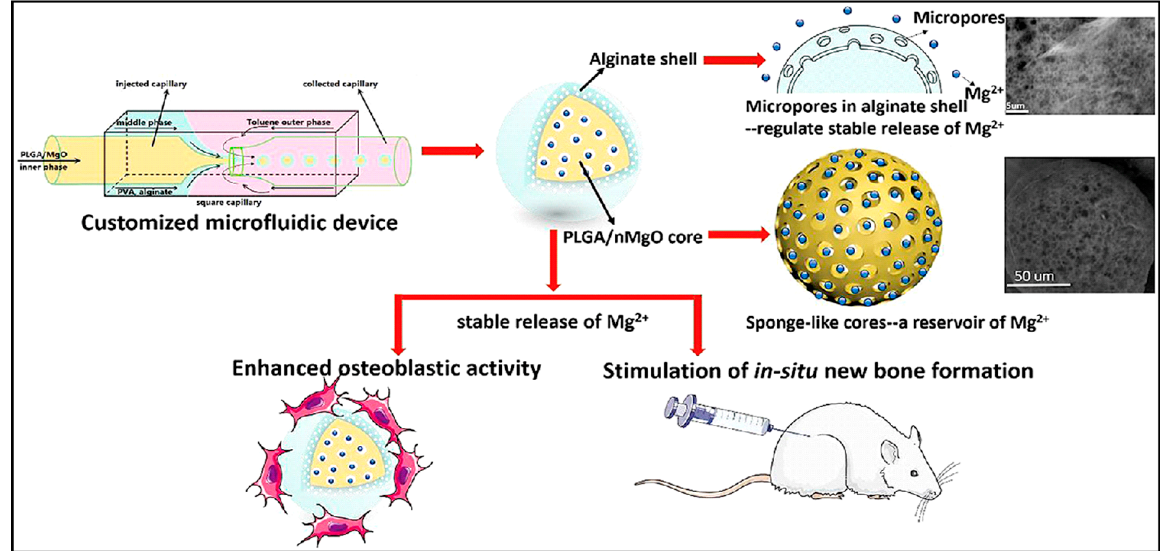
Figure 7. Schematic representation of PLGA/magnesium oxide nanoparticle core with alginate shell microsphere prepared using microfluidic capillary device and their osteoblastic activity in vitro and in situ bone regeneration in vivo. Reproduced with permission from [78].